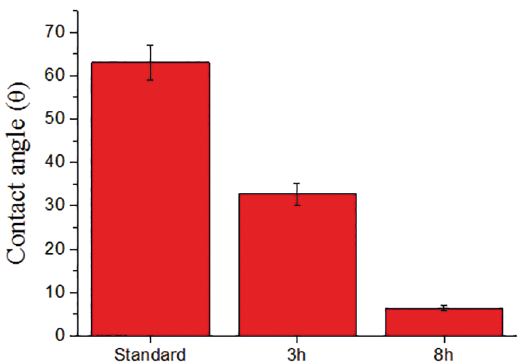
Figure 4. Graph of contact angle analysis for untreated and treated